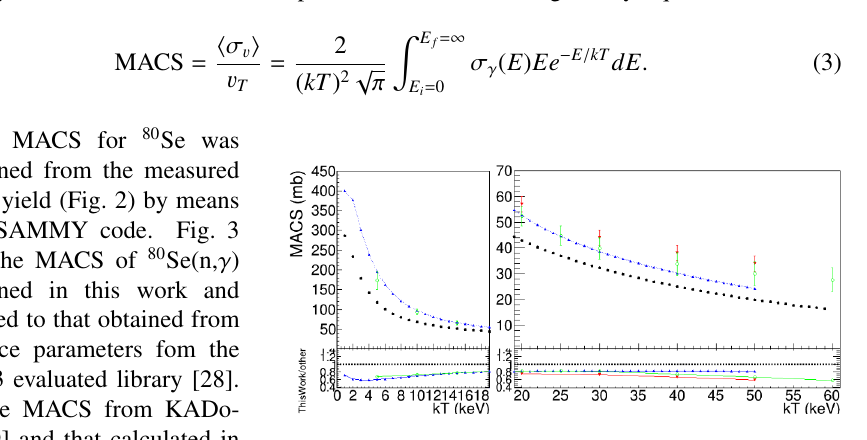
Figure 3. MACS of 80 Se(n, γ ) determined in this work com- pared to evaluated libraries and previous